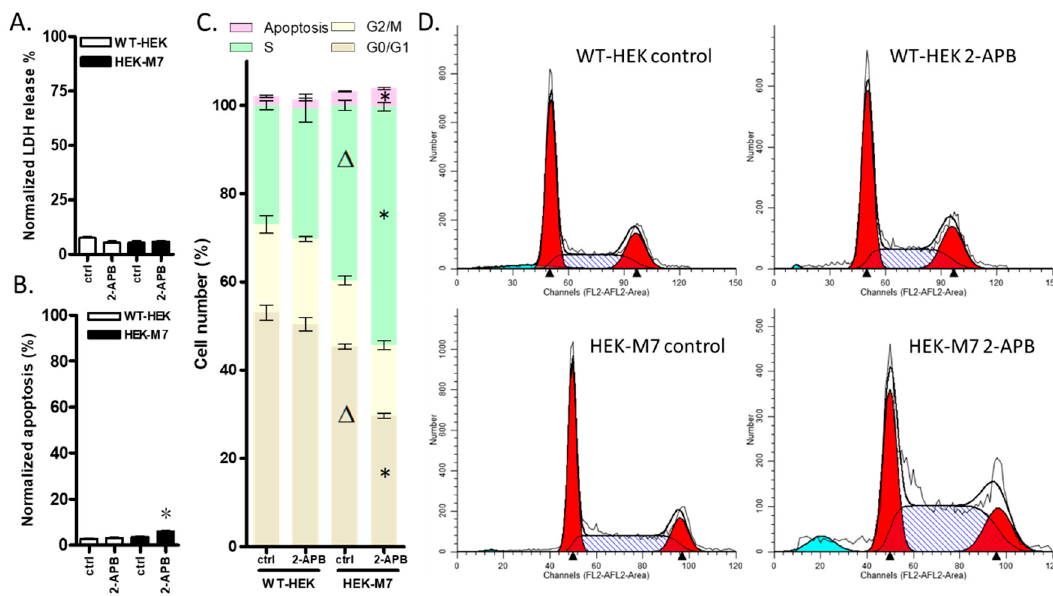
Figure 4. The role of TRPM7 channels in HEK cell biology. ( A – D ) show data for cells exposed to 200 µM 2-APB for 24 h. ( A ) lactate dehydrogenase (LDH) Release. 2-APB had no significant effect on LDH release in either WT-HEK or HEK-M7 cells. ( B ) Apoptosis. 2-APB induced a small but significant amount of apoptosis in HEK-M7 only. ( C ) Cell cycle analysis. Overexpression of TRPM7 caused an increase in the percentage of cells in the S phase and a corresponding decrease in the G0/G1 phase in HEK cells. 2-APB caused a further increase in the percentage of cells in the S phase and the corresponding decrease in the G0/G1 phase in HEK-M7 but did not affect the cell cycle of WT-HEK cells. ( D ) Representative images from the cell cycle assay of HEK cell lines. Significant differences ( p < 0.05) from control and wildtype control are indicated by “*” and “ Δ ” respectively.